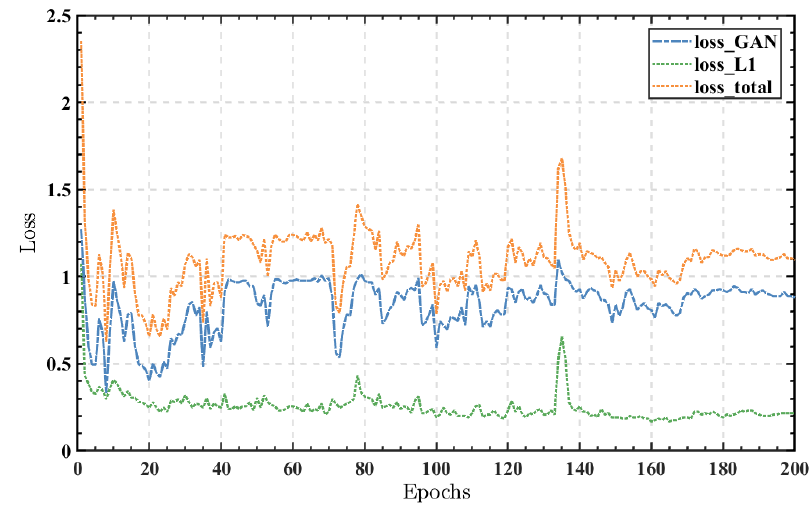
Figure 6. The loss curve of the network training process.